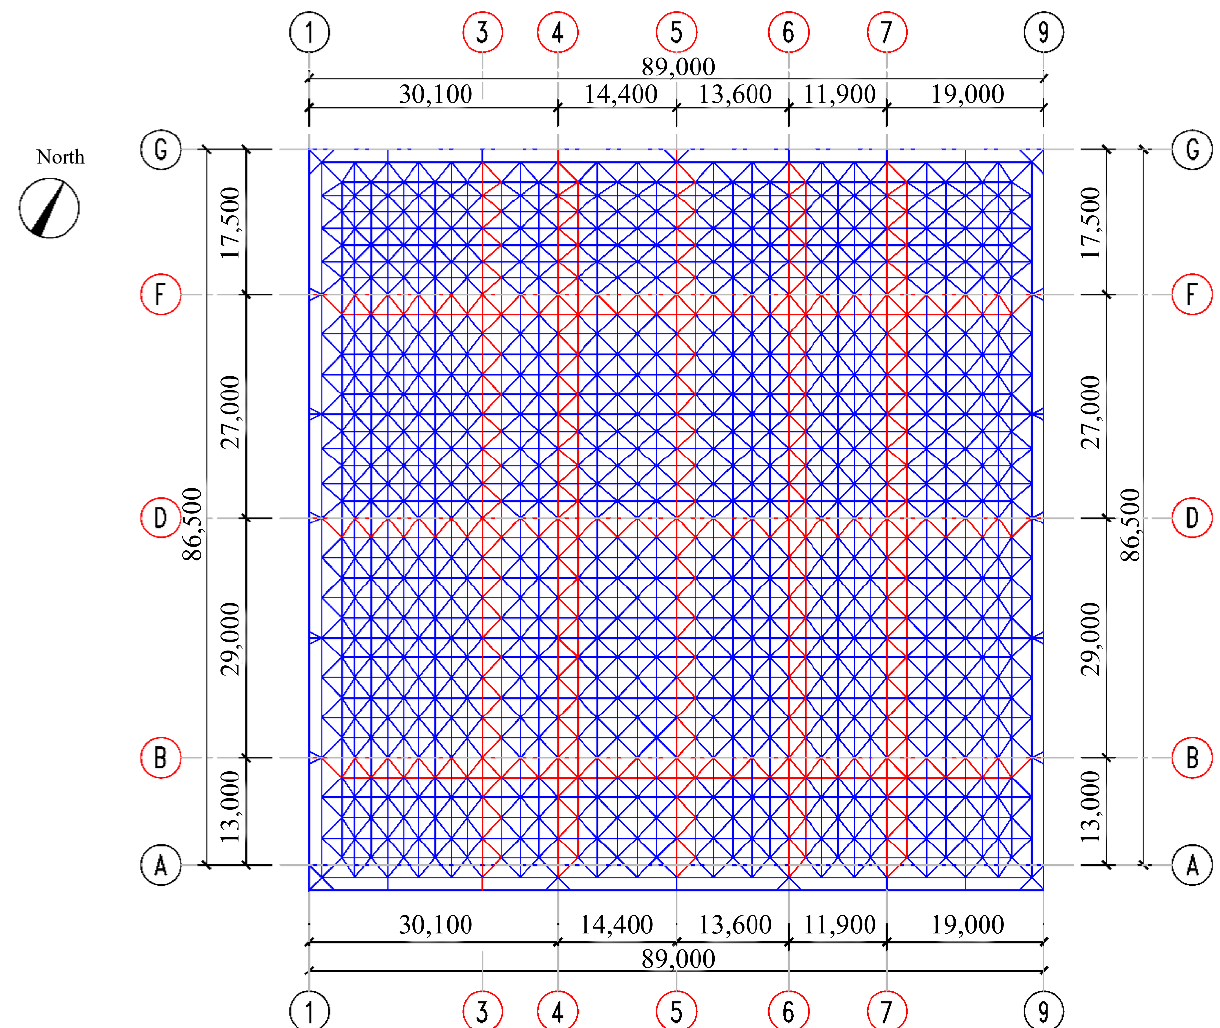
Figure 5. Converter station steel structure site.